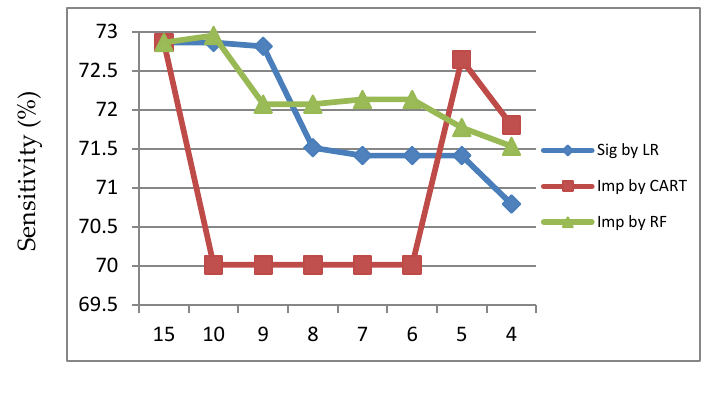
Figure 14. Sensitivity of CART with input of significant or important variables.